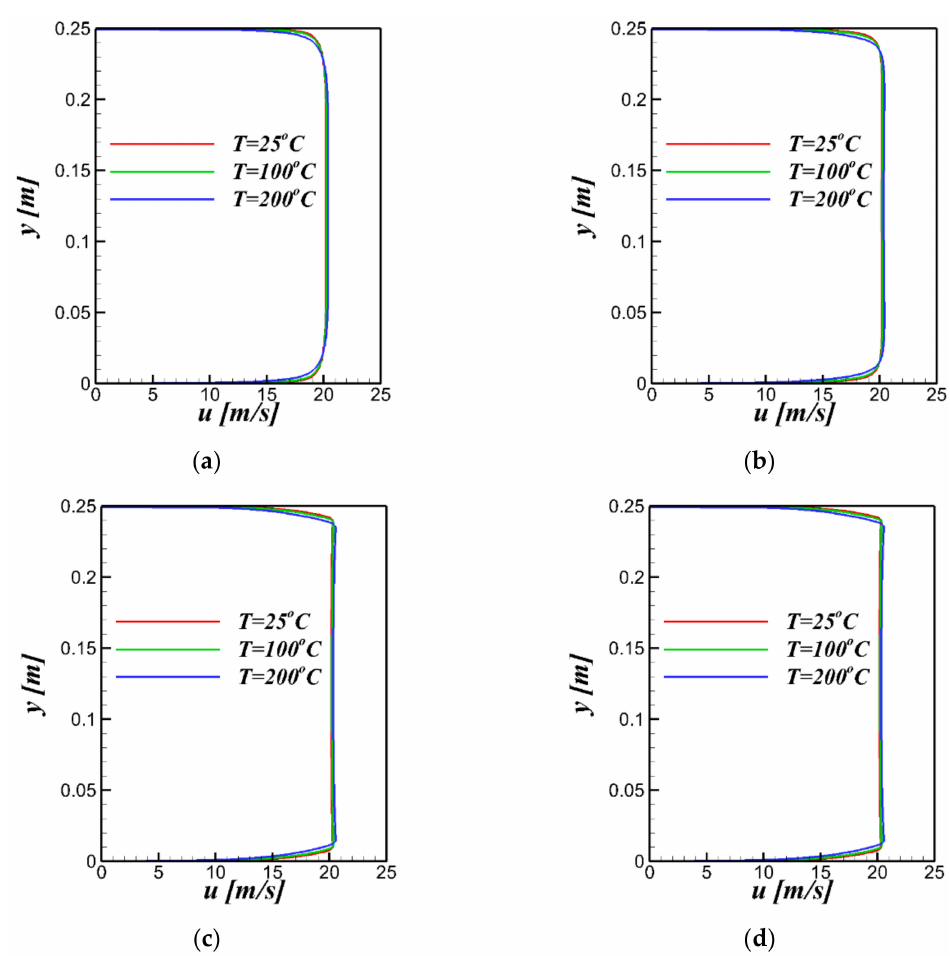
Figure 4. Velocity profile of temperature increases for the TI; ( a ) 0.5%, ( b ) 1%, ( c ) 10%, ( d ) 20%.